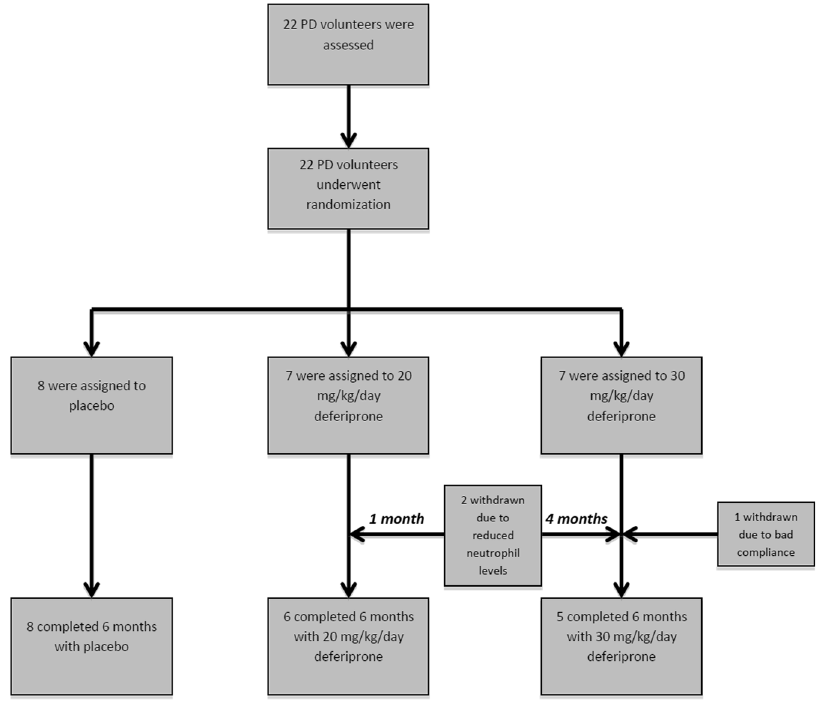
Figure 1. Flow diagram showing the random assignments of the two doses of deferiprone, 20 or 30 mg/kg and placebo to the 22 Parkinson’s disease